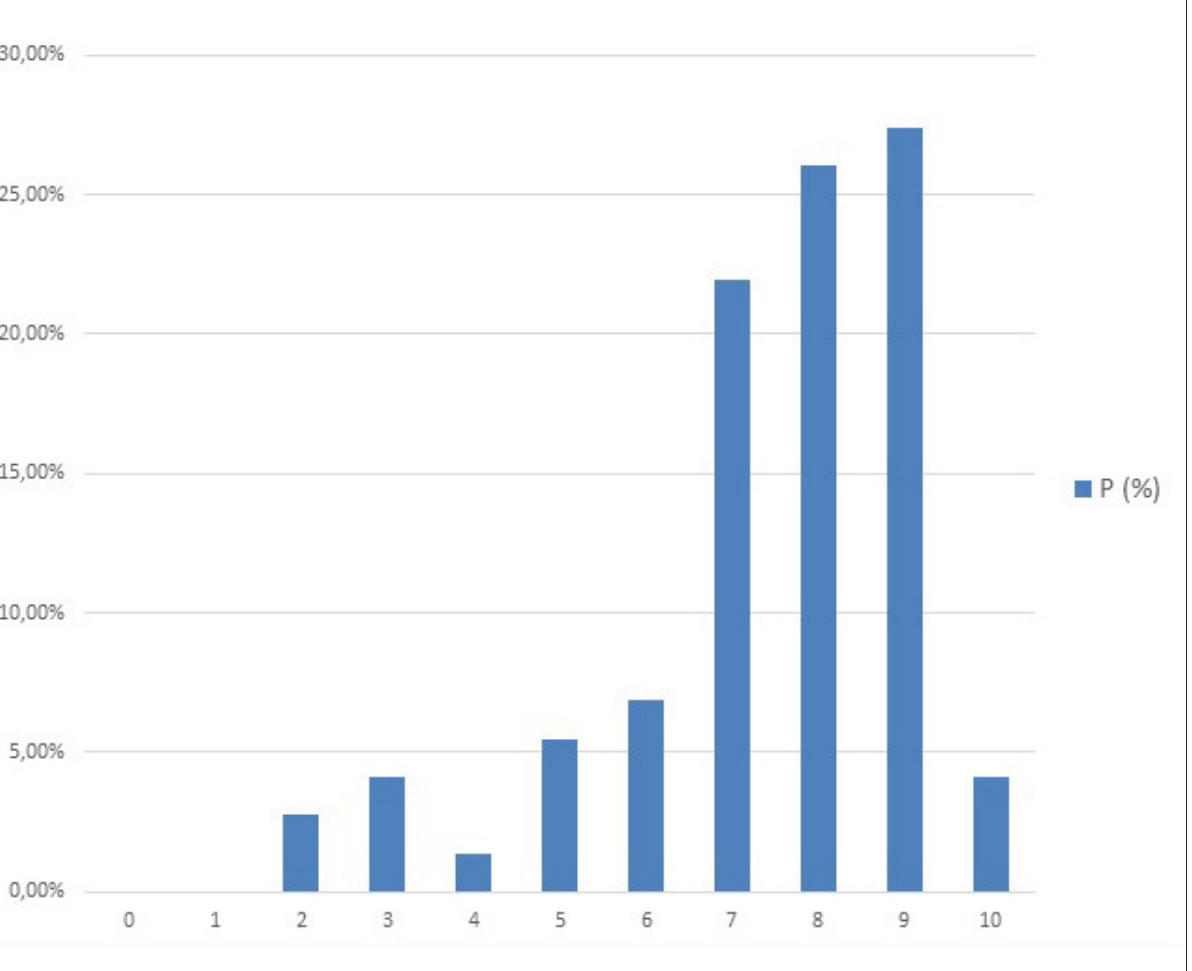
FIGURE2 Level of general satisfaction on telemedicine (range